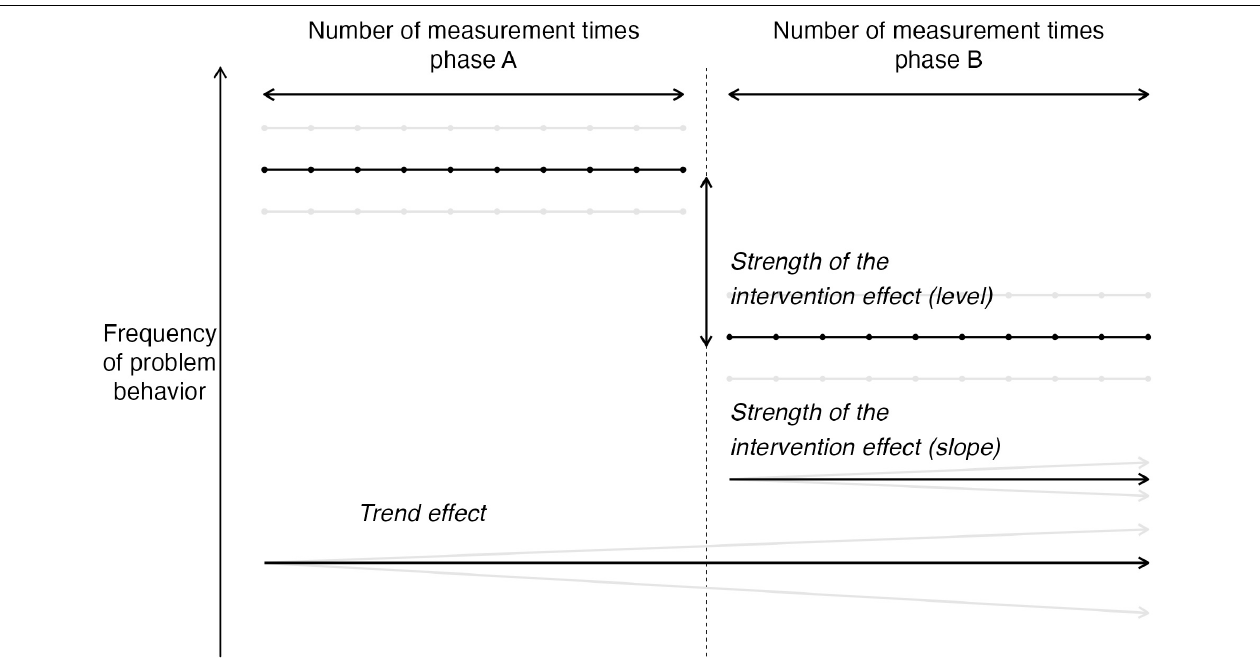
FIGURE 1 | Design specifications potentially influencing the test power of single-case experimental designs